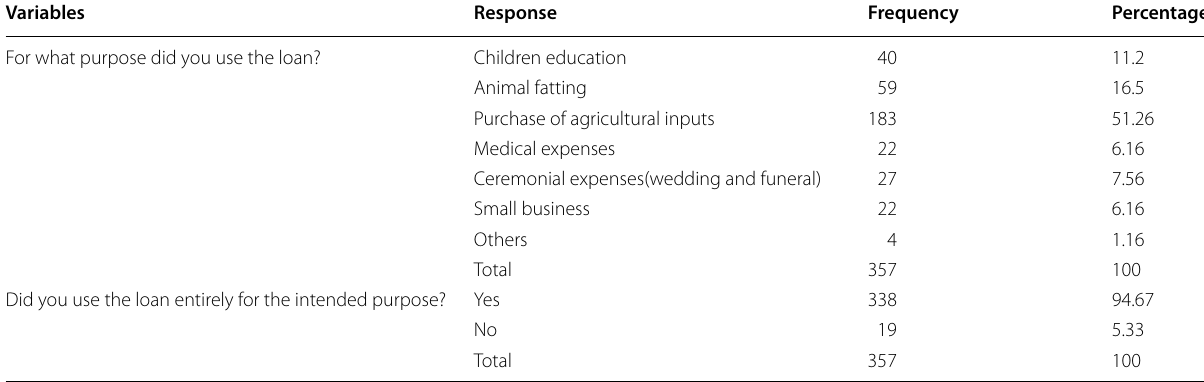
Table 3 Respondents’ loan purpose and usage. Source : Author’s Survey